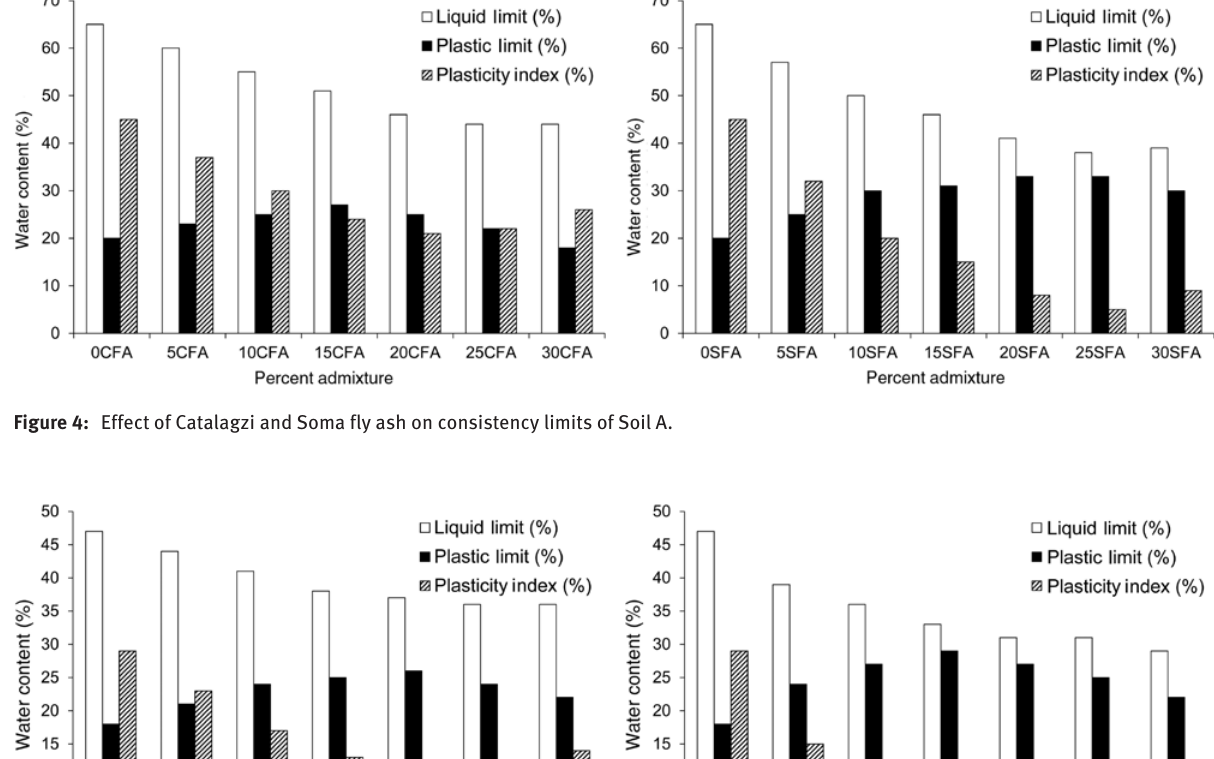
both fly ash addition and they tend to increase after this addition